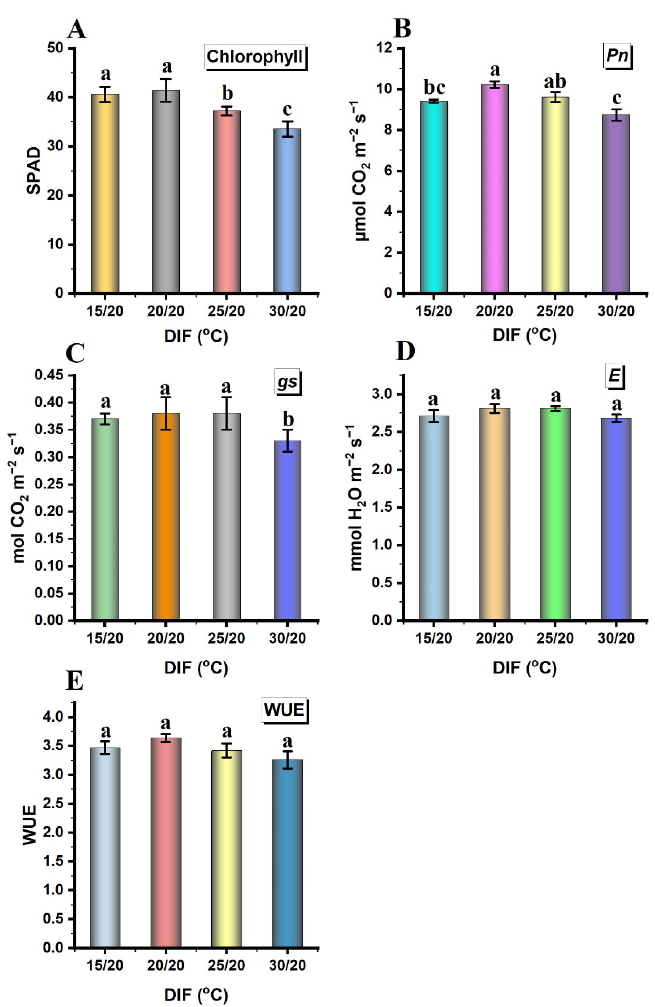
Figure 4. Effects of different day/night temperatures on the physiological, biochemical, and growth attributes of butterhead lettuce cv. Gustav, including ( A ) chlorophyll, ( B ) rate of photosynthesis ( Pn ), ( C ) stomatal conductance ( gs ), ( D ) transpiration rate ( E ), and ( E ) water use efficiency (WUE). Each bar is the mean of three independent biological replicates. The Ybar on each bar indicates the standard error within the mean. The statistical analysis is based on a singlefactor completely ran- domized design. The comparison of treatment means was performed by the least significance dif- ference (LSD) test for day/night temperatures. Different letters within each graph indicate signifi- cant mean differences, as compared by the LSD ( p ≤ 0.05).